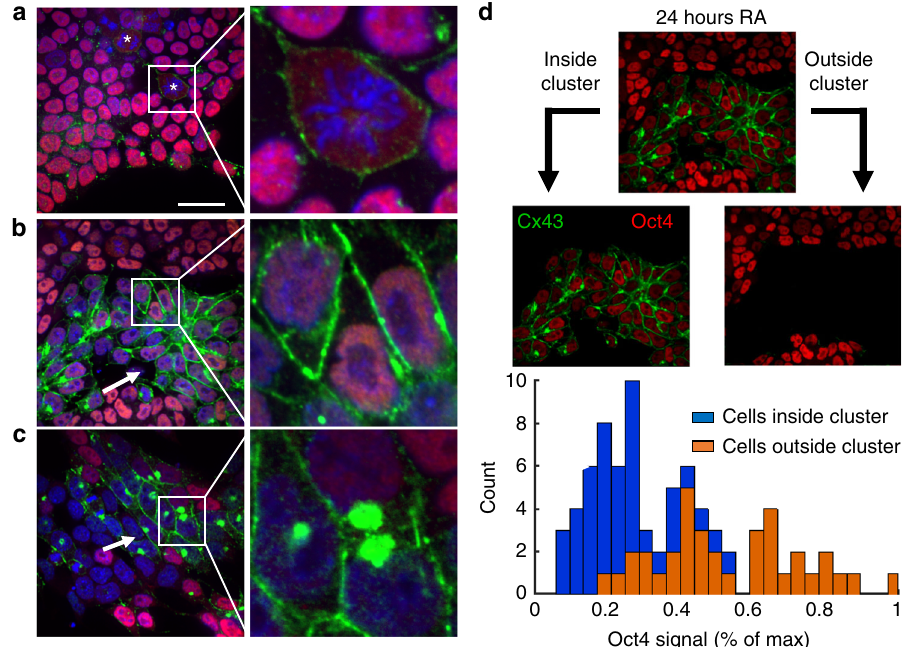
Fig. 2 Cx43 signal (green) increases during retinoic acid – induced differentiation, with compartmentalization of transitioning cells between 24 and 48 h. Mitotic cells are prevalent in pluripotent colonies ( a ) and show a diffuse ‘ ring ’ of Cx43 in the membrane, designated by an asterisk, that is typical of Cx43 not forming GJ plaques. After 24 h of RA treatment ( b ), Cx43 noticeably increased between clusters of cells with low Oct4 expression (red), characterized in d . At 48 h of treatment ( c ), cells that have low (but non-zero) Oct4 expression have large expression of Cx43 in the cytoplasm. Previous studies have linked an accumulation of Cx43 expression in the cytoplasm to localization in the Golgi apparatus, speci fi cally in proliferative neural progenitor cells. The average Oct4 intensity was calculated for cells that were inside and outside the clusters displaying enhanced Cx43 at 24 h ( d ). Cells within the Cx43- enhanced clusters at 24 h exhibited a signi fi cant lower Oct4 expression compared to cells outside of the cluster with low Cx43 signal. Scale bar: 30 µ